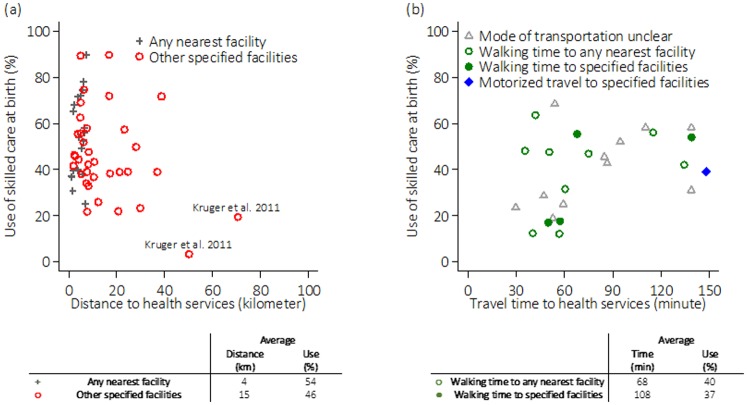
Summary of included studies’ mean levels of use of skilled care at birth against (a) average distance to health services in kilometres (km) and (b) average travel time to health services in minutes (min).